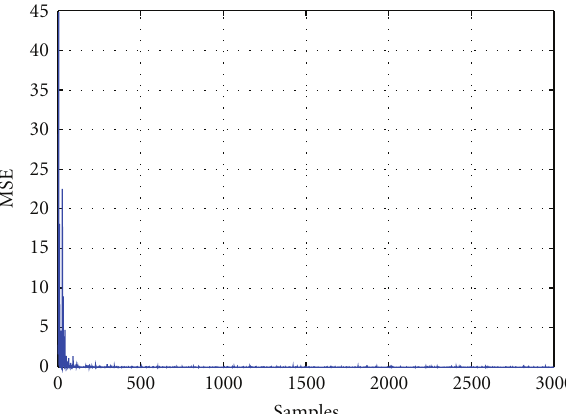
Figure 4: Mean square plot of PPN based noise prediction model for 3000 iteration.